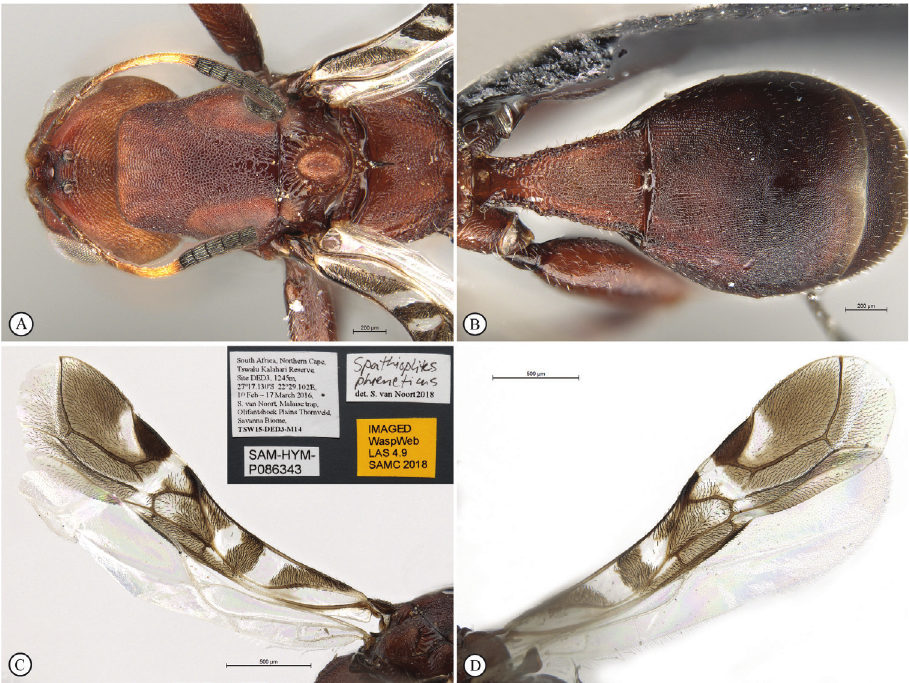
Figure 2. Spathioplites phreneticus , female South Africa SAM-HYM-P086343 (SAMC) A head, mesoso- ma, dorsal view B metasoma, dorsal view C left wings, dorsal view (inset: data labels) D right wings, dorsal view (note that both sets of depicted wings ( C, D ) have dried in a contorted manner and are curved and folded, distorting dimensions of the constituent cells, which is evident when comparing the two